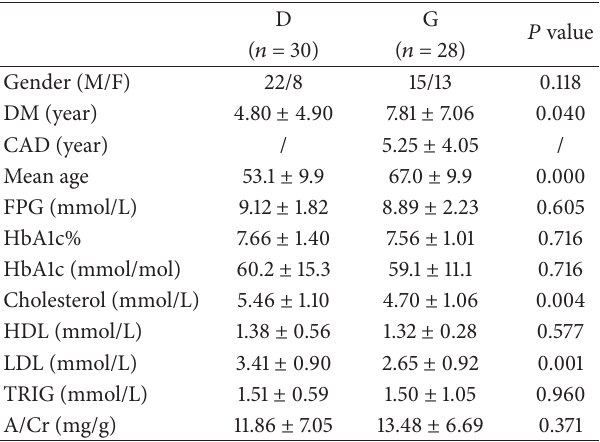
Table 1: Demographics and clinical characteristics of two groups of type 2 diabetes